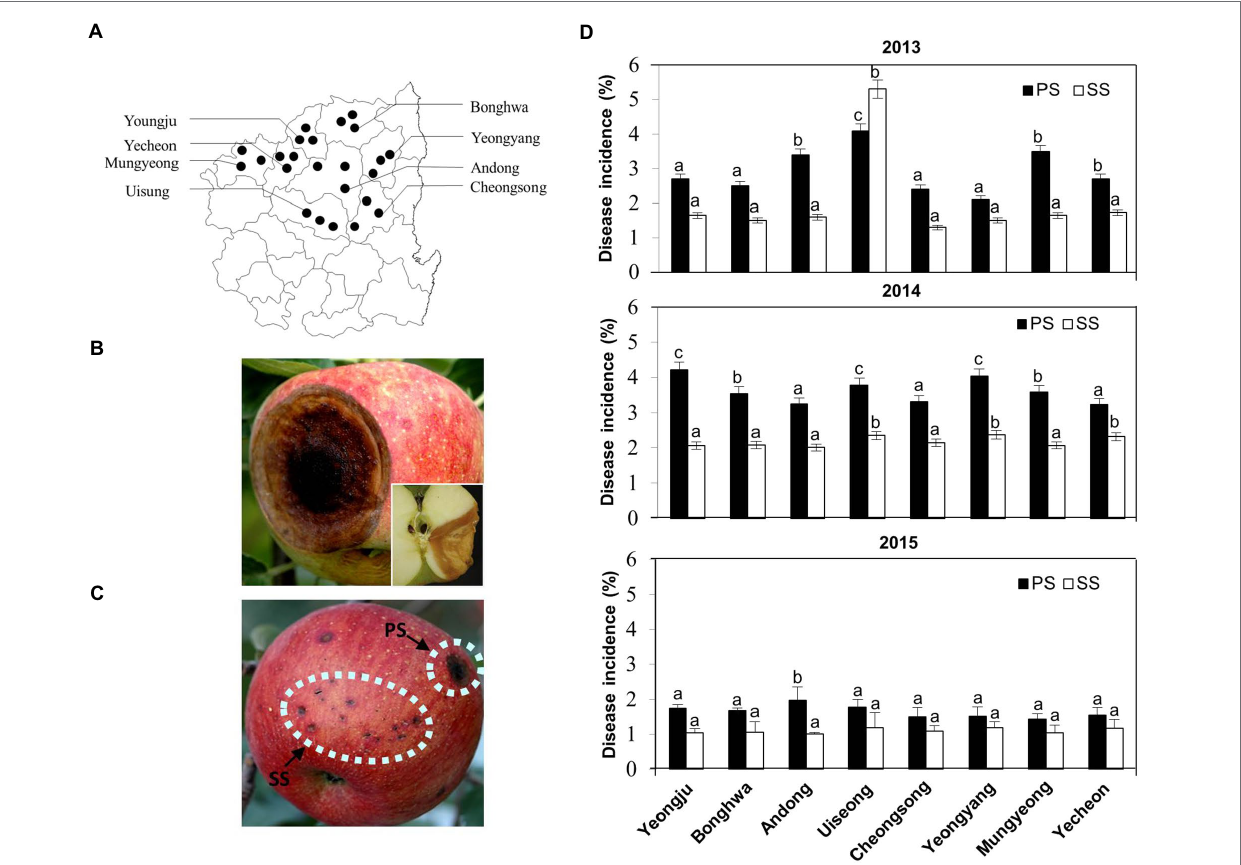
FIGURE 1 | Disease occurrences in apple orchards in Korea over 3 years. (A) Distribution of disease occurrences in apple orchards at various locations of the northern Gyeongbuk Province of Korea. (B) Typical progressive symptoms (PS) of anthracnose appear as round, brown, shrivelled, and sunken spots, with orange conidial masses on the surface of the matured fruits. A longitudinal section of the fruit shown at the corner represents the disease spread as “V” shape inside the fruit. (C) An apple fruit showing both types of progressive symptoms (PS) and static symptoms (SS) of anthracnose disease caused by Colletotrichum gloeosporioides on the apple fruit in field conditions. (D) Occurrence of disease incidence (%) of anthracnose as PS and SS on apple fruits at different locations in the northern Gyeongbuk Province of Korea over 3 years, 2013, 2014, and 2015. From each location, 20 samples were collected. Bars with the same letters do not differ statistically from each other, according to the least significant difference (LSD; p <